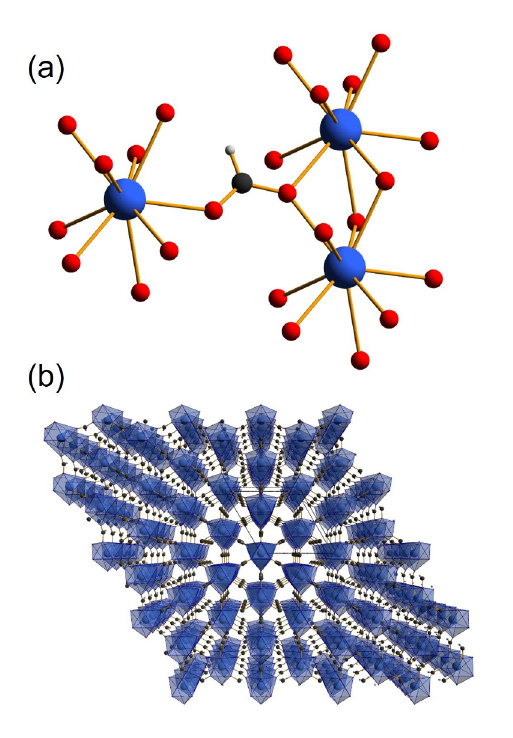
Figure 2. View of the obtained La/Tb-MOF structure: (a) coordination environment of Ln 3+ (b) and partially expanded framework. Color code: black (carbon), red (oxygen), gray (hydrogen) and blue (lanthanum or terbium).